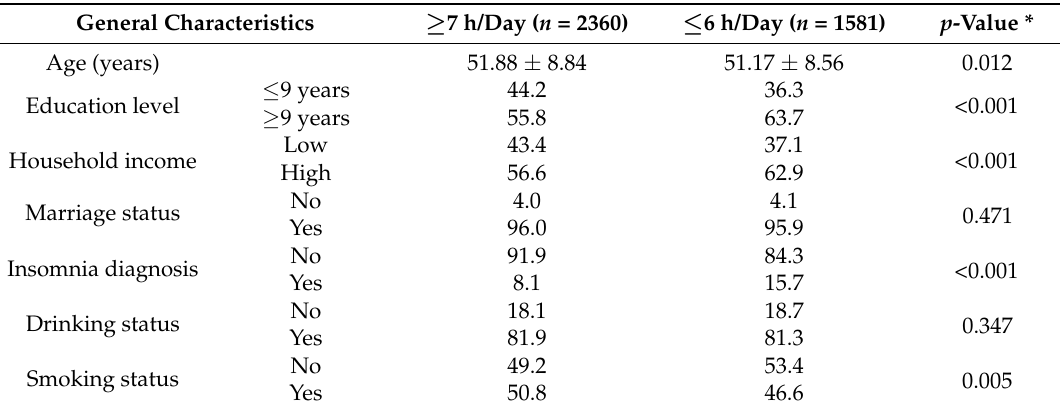
Table 1. General characteristics according to sleep duration in Korean